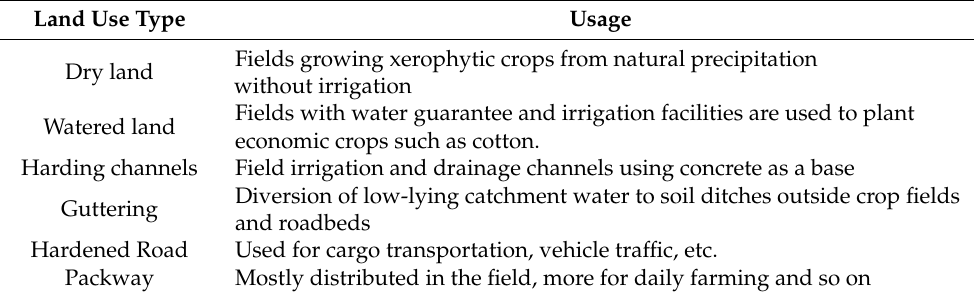
Table 1. Use of different land use types in the project area. Land Use Type Usage Fields growing xerophytic crops from natural precipitation Dry land without irrigation Fields with water guarantee and irrigation facilities are used to plant Watered land economic crops such as cotton. Harding channels Field irrigation and drainage channels using concrete as a base Diversion of low-lying catchment water to soil ditches outside crop fields Guttering and roadbeds Hardened Road Used for cargo transportation, vehicle traffic, etc. Packway Mostly distributed in the field, more for daily farming and so